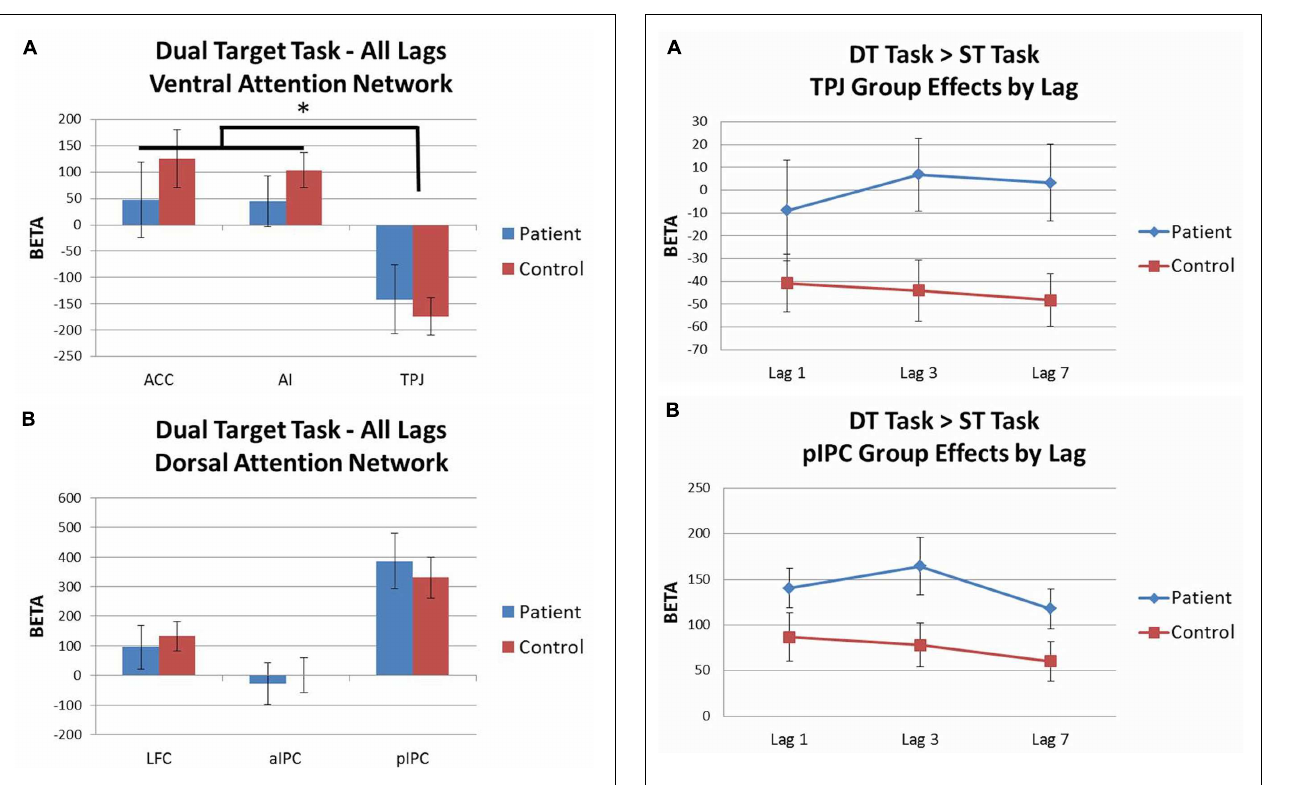
FIGURE 5 | Dual target task ROI analysis by network (all lags combined; contrast: dual target task > baseline). (A) Ventral attention network: both groups showed activation of ACC and AI, but deactivation of TPJ. (B) Dorsal attention network: no significant group differences. ∗ p < 0.05.